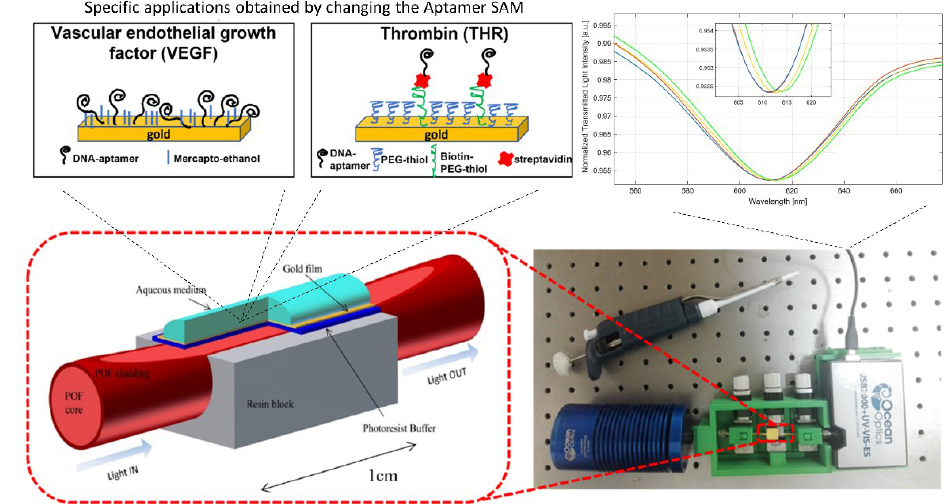
Figure 4. SPR D-shaped POF aptasensor. Zoom of the resonance sensing region with two examples of self-assembled monolayer of aptamers.